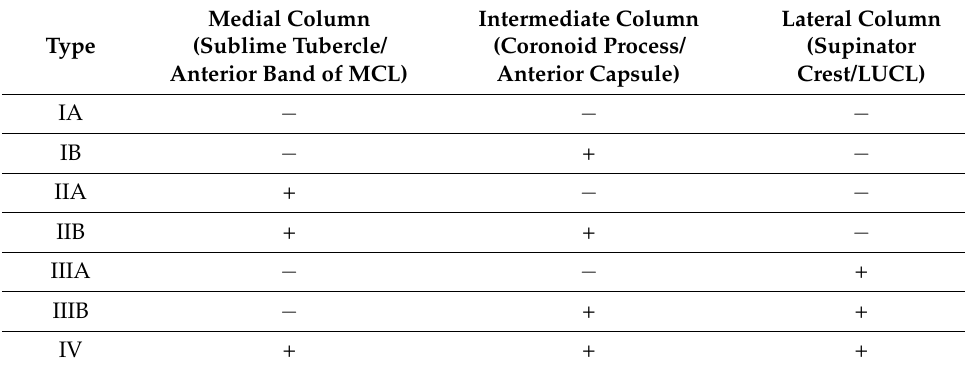
Table 2. Affected column structures according to type in the new